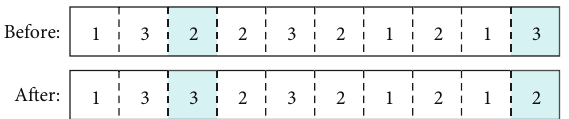
Figure3:Anindividualwithtenaircraftsbeforeandafterswaplocal